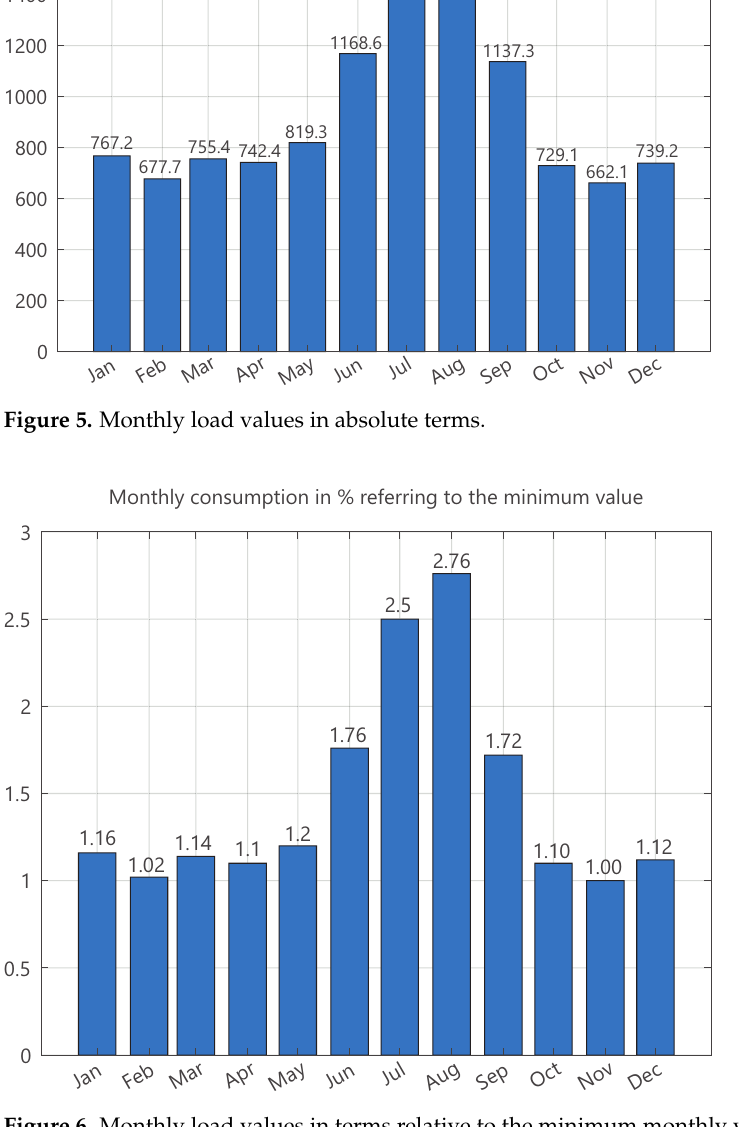
Figure 6. Monthly load values in terms relative to the minimum monthly